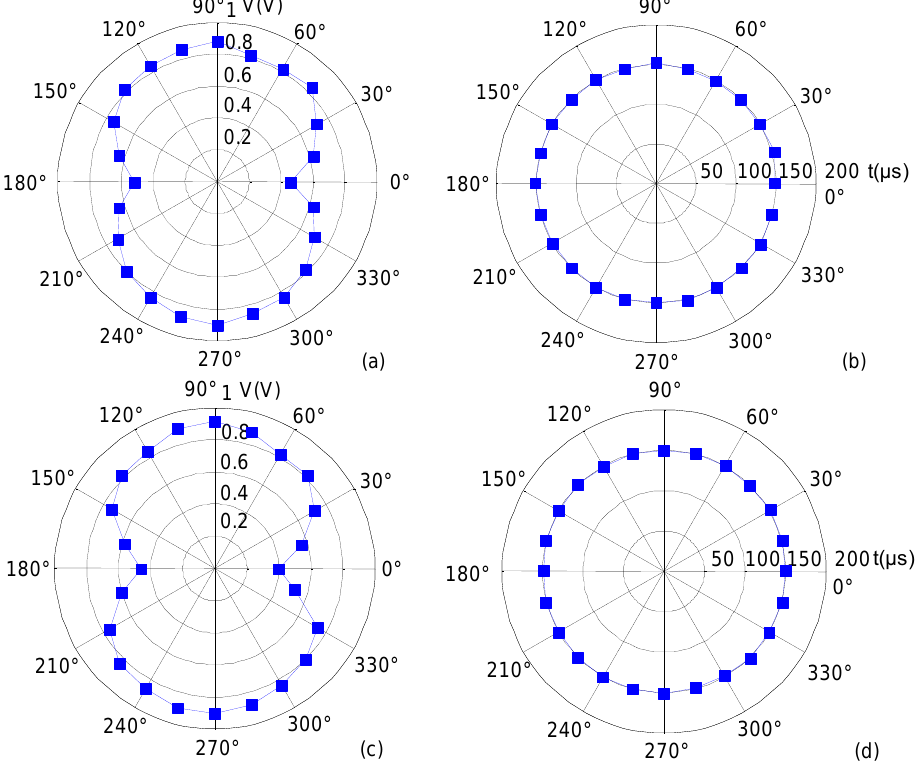
Figure 9. Results of the circumferential consistency verification experiments: ( a ) V of the different transmitter directions; ( b ) t of the different transmitter directions; ( c ) V of the different receiver directions; and ( d ) t of the different receiver